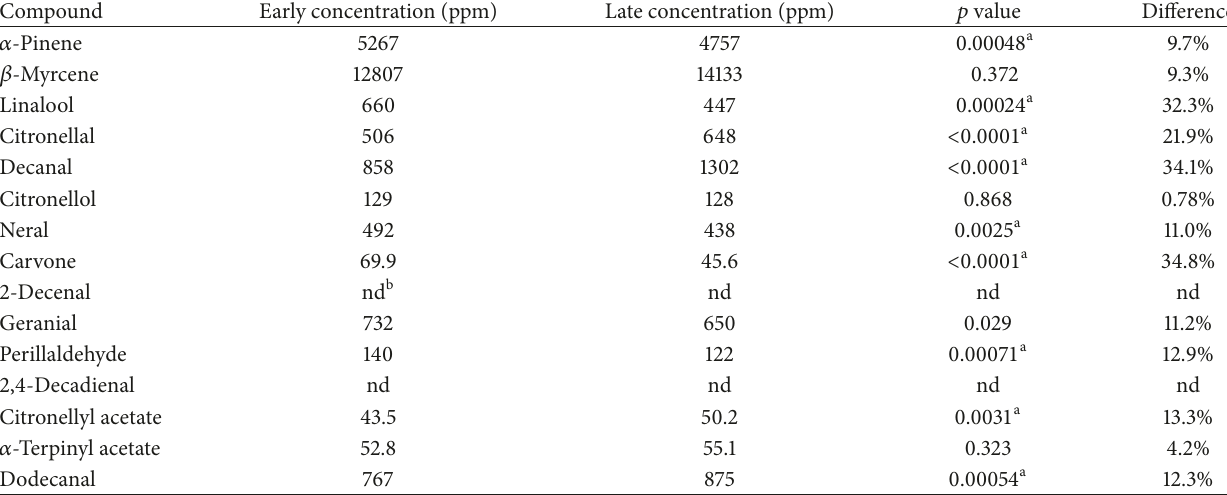
Table 7: Hamlin asymptomatic early versus late compound concentration.